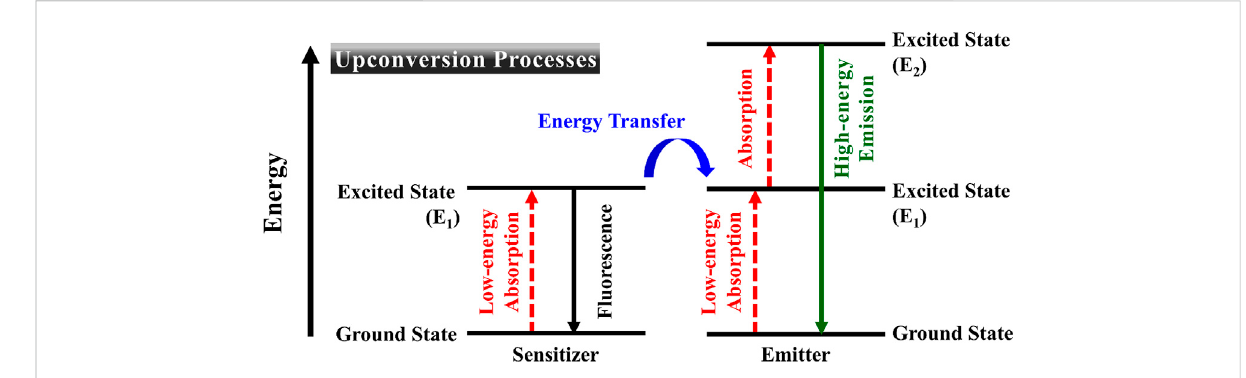
FIGURE 5 Upconversion processes involving low-energy photons absorption and energy